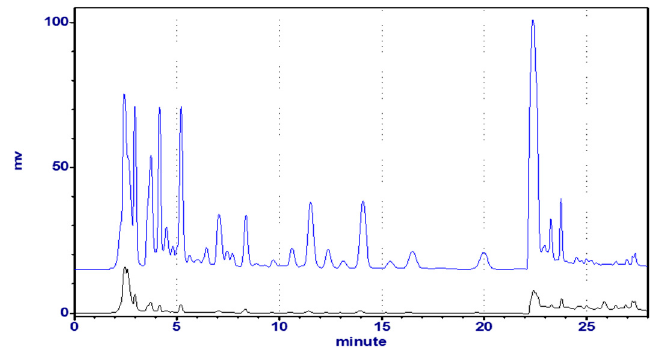
Figure 5. HPLC chromatograph comparison of extraction times (Blue: the first extract, black: the second extract).